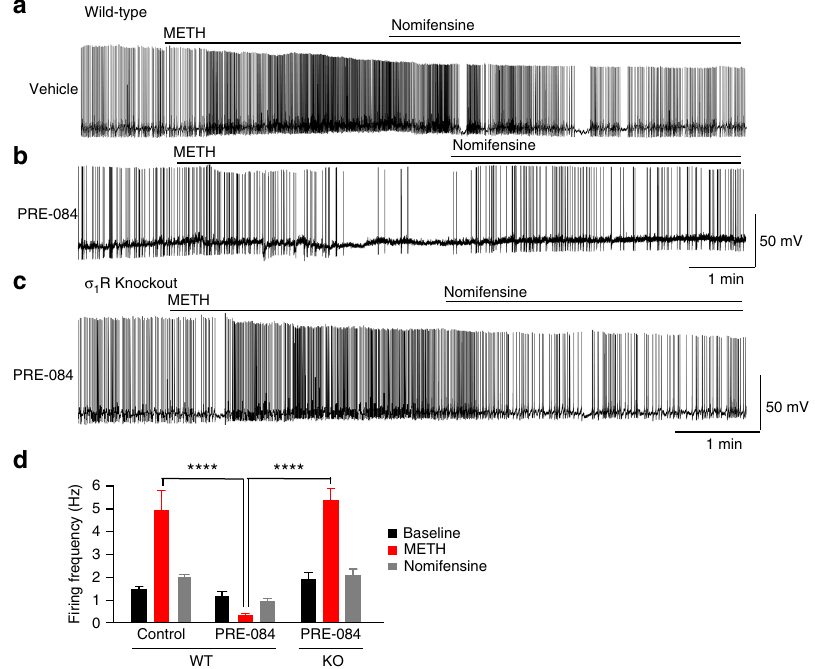
Fig. 2 σ 1 R activation decreases METH-stimulated fi ring activity in dopaminergic neurons of midbrain slices in wild-type but not σ 1 R knockout mice. Slice recordings were performed in ventral tegmental area slices derived from 4 to 6-week-old mice. a Representative trace of spontaneous fi ring activity reveals METH-mediated (10 μ M) increases fi ring activity that are blocked with application of nomifensine (10 μ M) ( n = 8 neurons). b While baseline activity was unaffected, 30-min pretreatment with 10 μ M PRE-084 blocked the ability of METH to increase the fi ring activity in the dopamine neurons. Application of nomifensine returned the fi ring rate to baseline ( n = 9 neurons). c 30-min pretreatment with 10 μ M PRE-084 in σ 1 R knockout mice resulted in no change in the METH-induced increase in fi ring activity, supporting the conclusion that the effect of PRE-084 on METH-stimulated fi ring activity is σ 1 R-dependent ( n = 8 neurons). d Bar graph shows the spontaneous fi ring rate (spikes per second) in different treatment groups at baseline, after METH treatment, and after subsequent nomifensine treatment ( F (4,50) = 19.52, P < 0.0001, two-way ANOVA; Tukey ’ s test for multiple comparisons within baseline, METH,